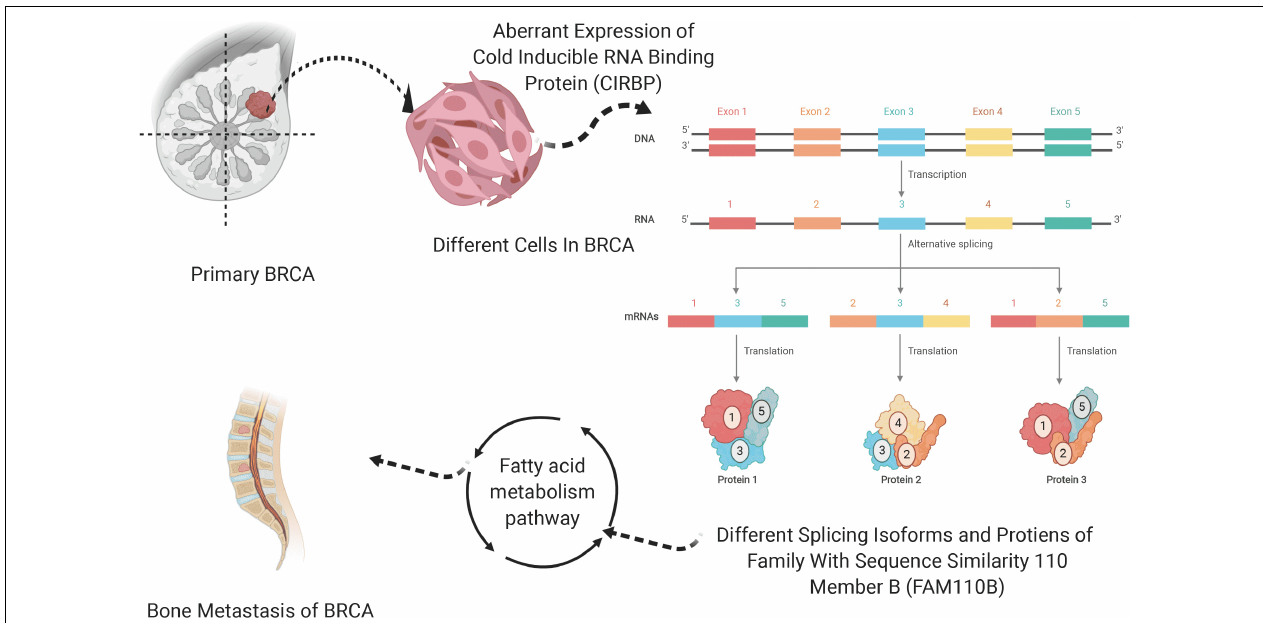
FIGURE 7 | Schematic diagram of the scientific hypothesis. OS-SEs (FAM110B-83922-ES) regulates SF (CIRBP) by the downstream pathway (Fatty acid metabolism